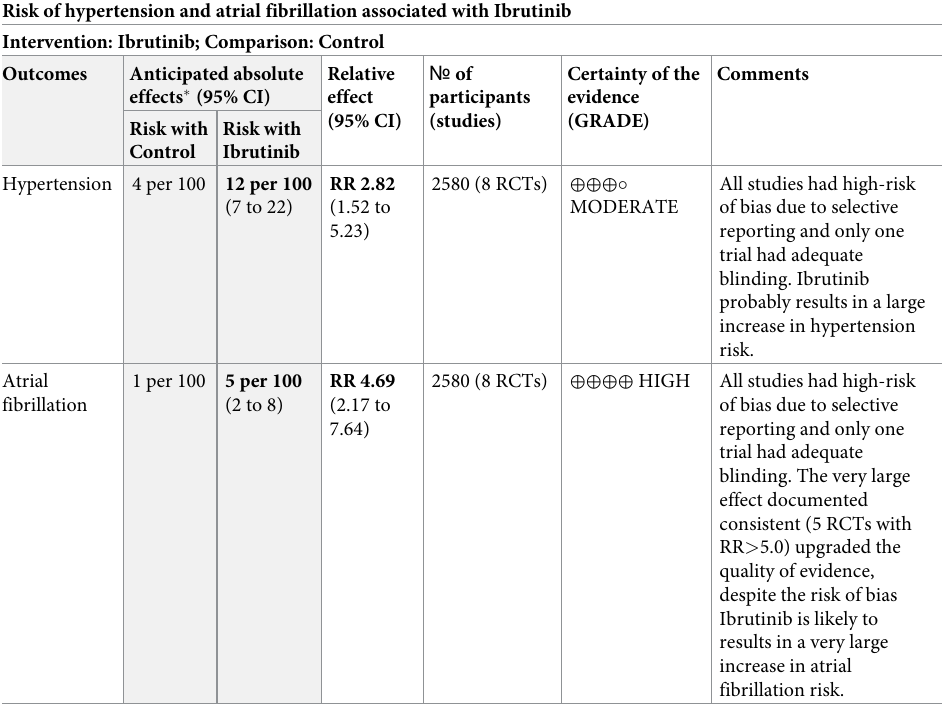
Table 2. Summary of findings table–GRADE